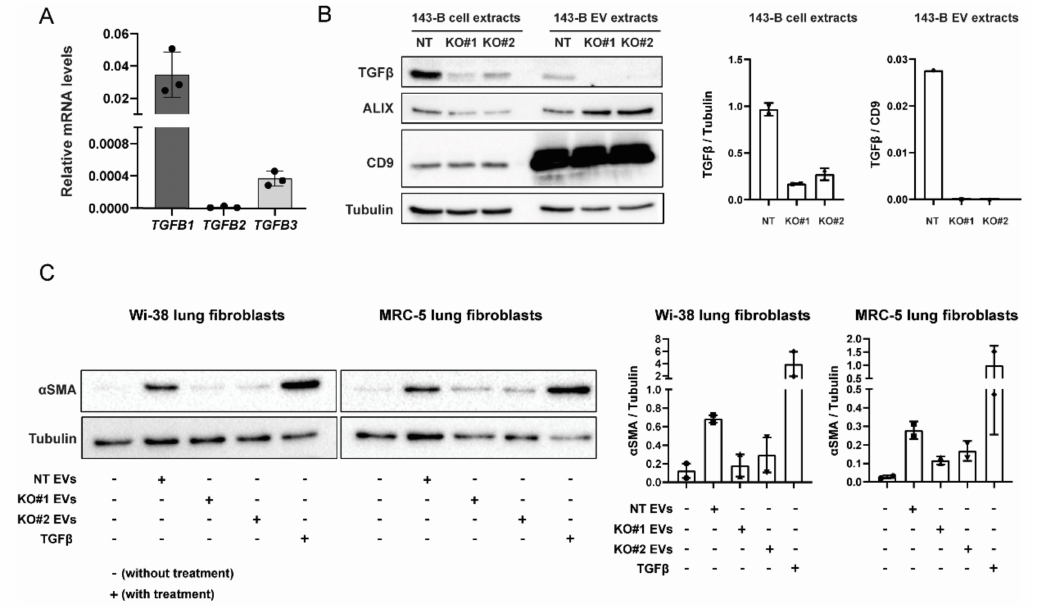
Figure 5. CRISPR-Cas9-mediated knockout of TGFB1 prevents 143-B-derived EVs from inducing lung fibroblast di ff erentiation. ( A ) mRNA expression levels of indicated TGF β isoforms (relative to GAPDH ) in 143-B osteosarcoma cells as determined by qRT-PCR. ( B ) Western blot analysis of TGF β 1 protein expression was used to validate the e ffi ciency of CRISPR-Cas9-mediated genome editing in non-targeting control (NT) 143-B, TGF β 1 KO#1 143-B, and TGF β 1 KO#2 143-B cell extracts and, respectively, derived-EV protein extracts. Cell extracts were harvested 4-5 passages after the initial viral transduction. Protein levels of EV markers (CD9 and ALIX) were examined by Western blot. ( C ) Western blot analysis of α SMA expression in WI-38 fibroblasts and MRC-5 fibroblasts following 48 h incubation with 20 µ g / mL of EVs derived from control NT 143-B cells, TGF β 1 KO#1 143-B cells and TGF β 1 KO#2 143-B cells. Soluble TGF β (10 ng / mL was used as the positive control. Tubulin was use as a loading control. Representative Western blots (left panels) and respective quantitative analysis of two independent experiments (right